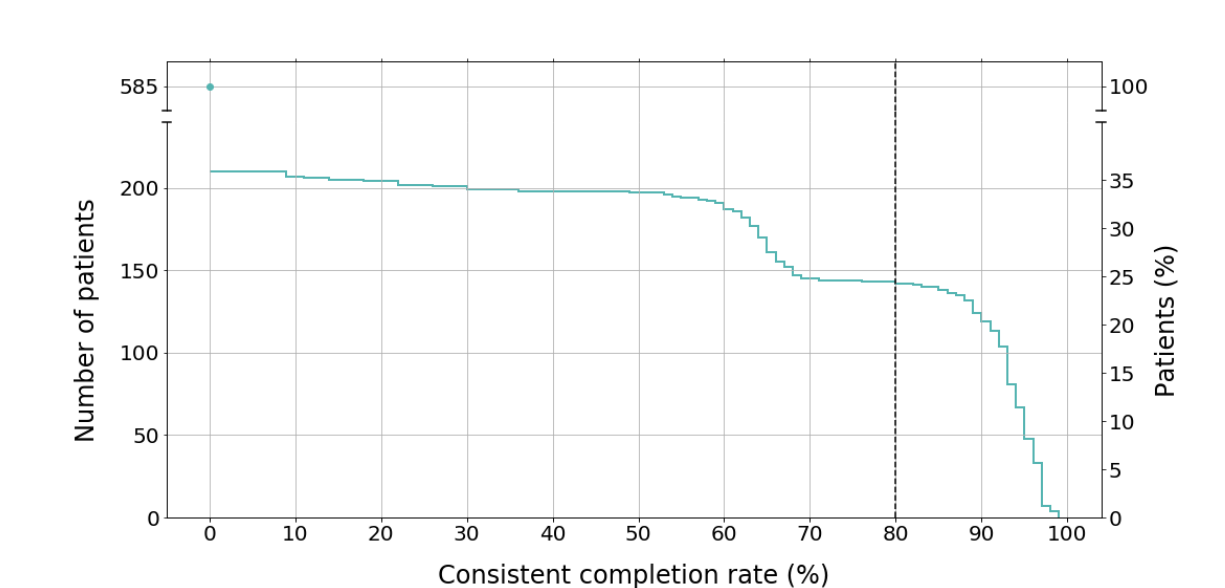
Figure 2. Relationship between completion rate continuity and number of participants.